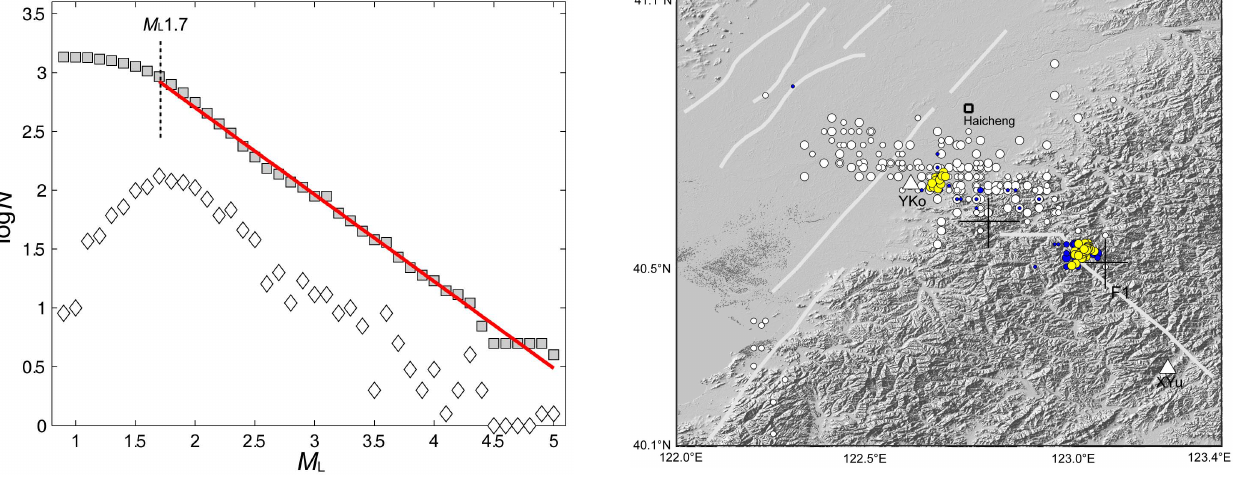
Fig. 3. Frequency-magnitude distribution of the events in the dashed box (39.9 ∼ 41.3 ◦ N, 121.8 ∼ 123.6 ◦ E) in Fig. 2, consist- ing of 1358 events, showing the completeness of the sequence se- lected. Light grey squares show the cumulative magnitude distri- bution, while white diamonds show the magnitude distribution it- self (the differential distribution). Red solid line fits the Gutenberg- Richter’s law. Completeness magnitude can be selected by visual inspection as M L =1.7 according to the end of the power-law-like frequency-magnitude distribution, seen both from the cumulative and the differential distribution curves. In the study, completeness magnitude is selected more conservatively as M L =1.9.